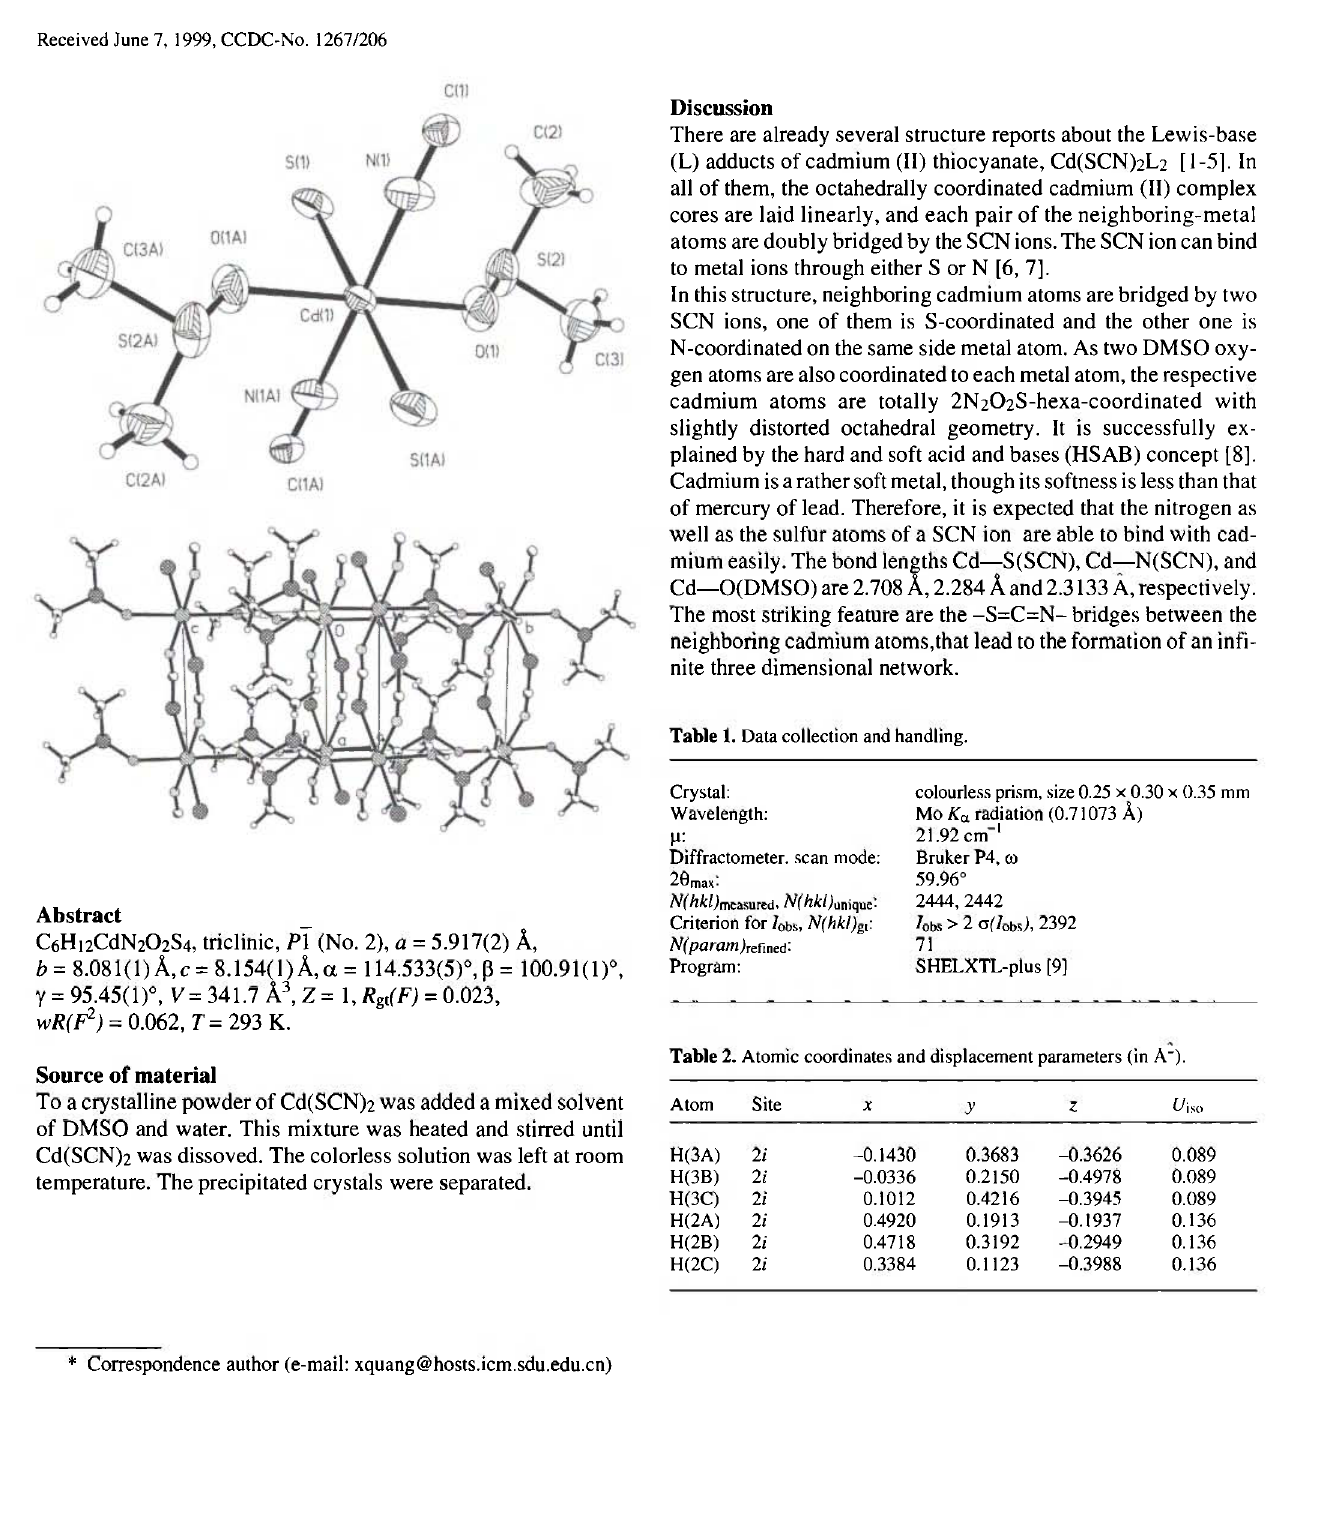
Table 2. Atomic coordinates and displacement parameters (in